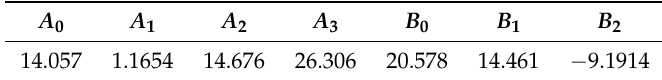
Table 2. Approximated function